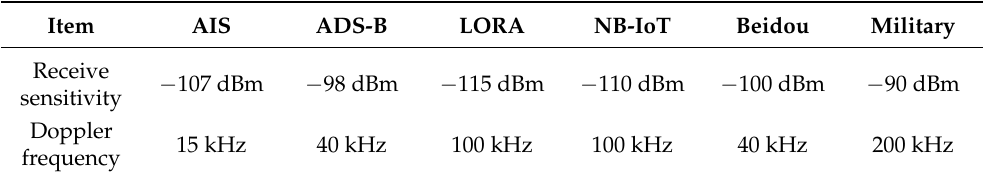
Table 6. SDR receiver performance optimization